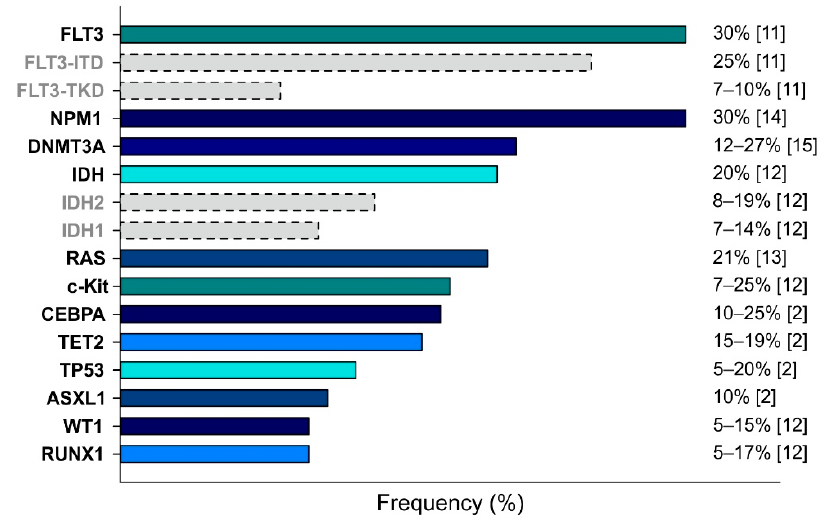
Figure 1. Main genetic mutations detected in AML cases. Mutations are ranked by frequency (indicated on the right). Dotted bars indicate the partial contributes of the specific subtypes.